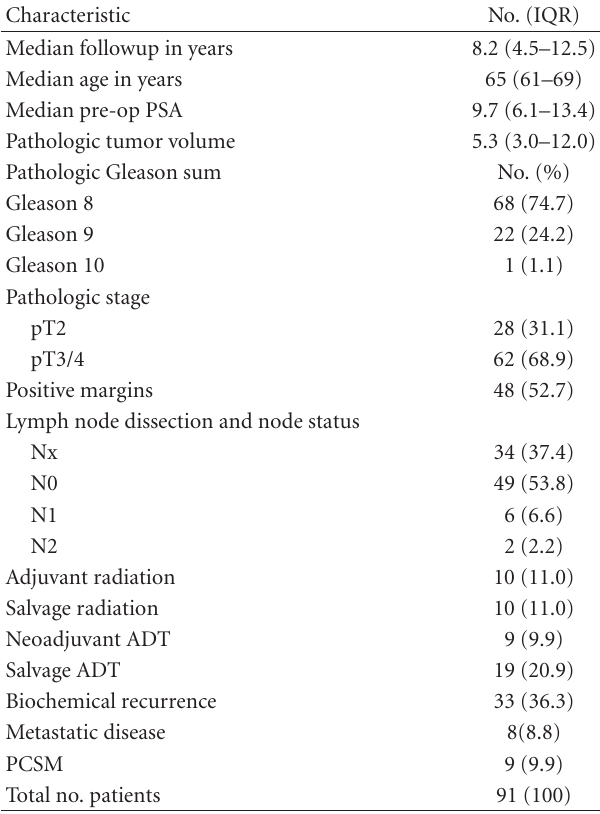
Table 1: Demographics and pathologic and clinical outcomes.